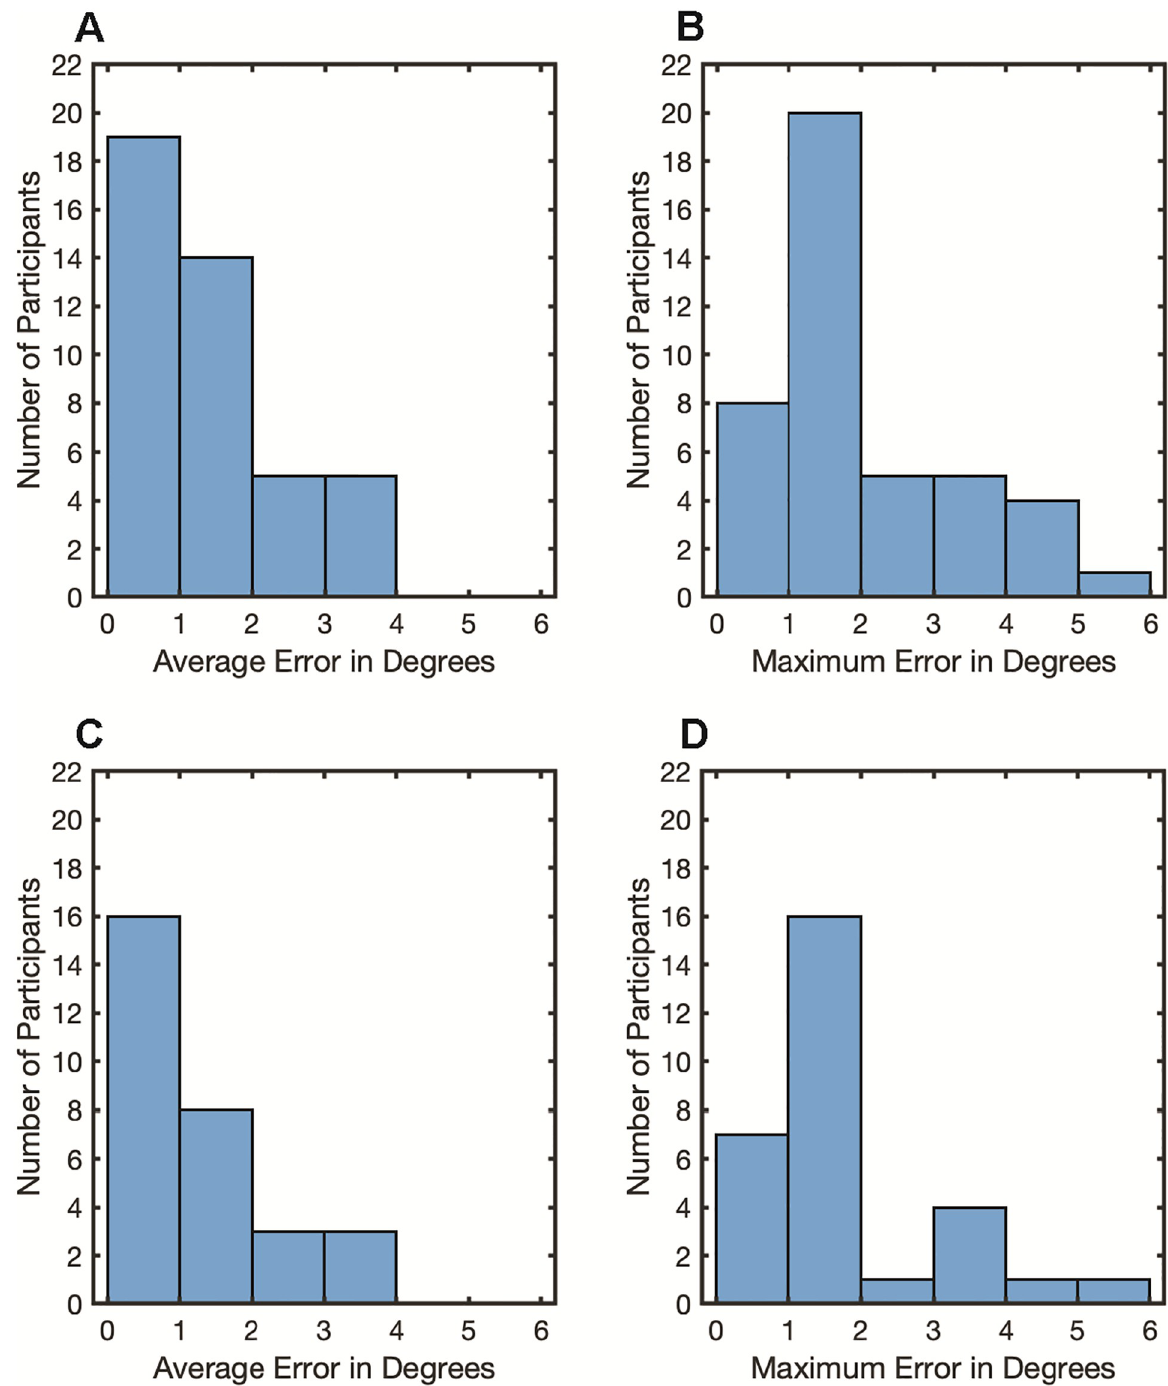
Fig 7. Histograms of calibration and validation error. Average error and maximum error during the calibration and validation procedure for the participants for whom eye-tracking was attempted and calibration was obtained (n = 51) (A, B) and participants whose data met data quality thresholds for subsequent analysis of oculomotor metrics (n = 32) (C, D). Error values indicate the amount of offset between the center of the calibration graphic and the reported x,y coordinates of the gaze sample. If monocular data was collected, values are reported for the recorded eye. If binocular data was collected, values are reported for the eye with higher calibration quality.